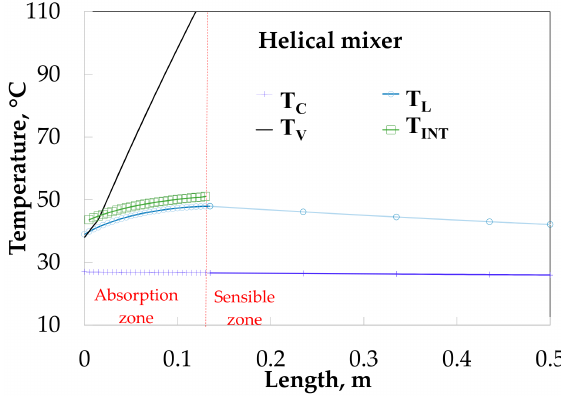
Figure 12. Temperature profiles along the absorber with absorption.